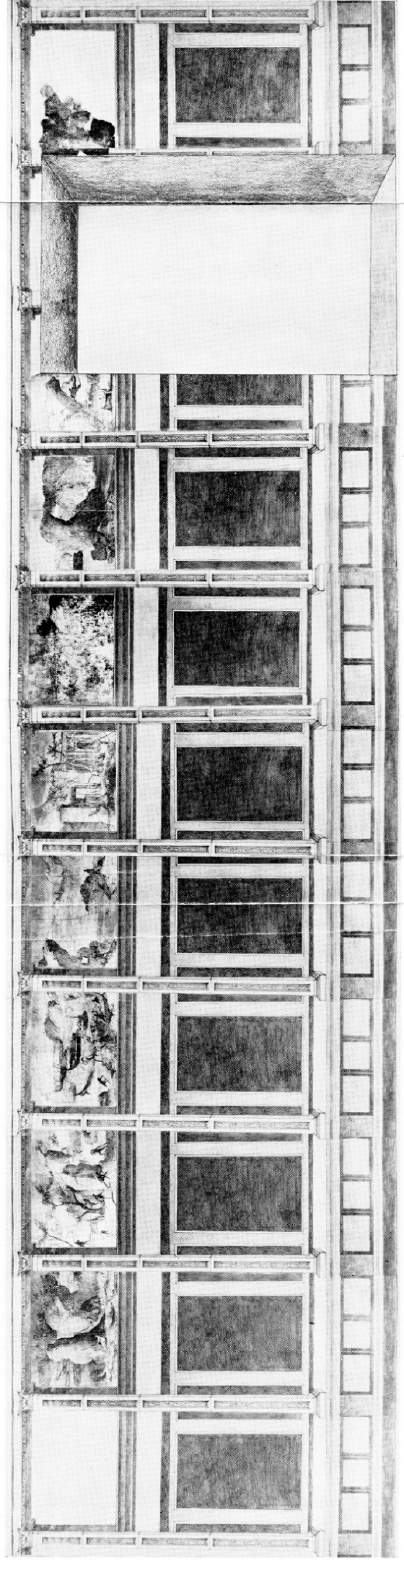
Figure 14. Reconstruction by B. Andreae of the second-style wall with the Odyssey frescoes from the Esquiline; Repro from (Andreae 1962), pl. 1, Figure 4 (with kind permission).